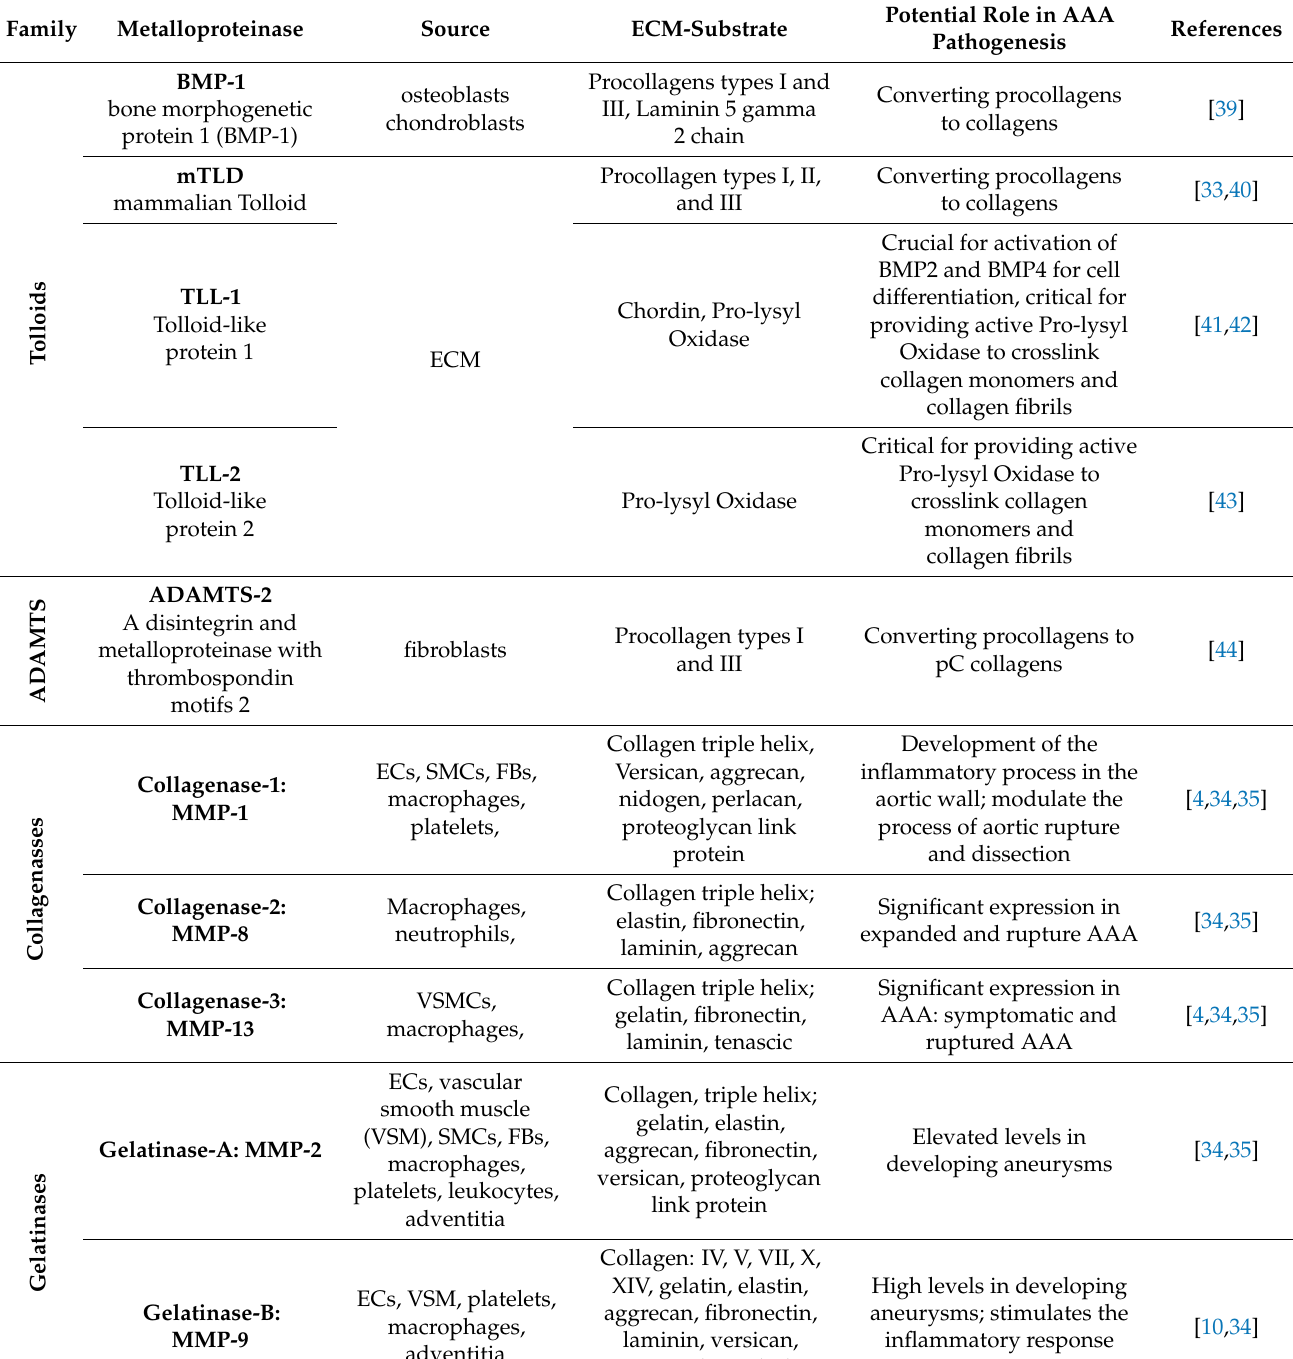
Table 2. Classification of selected metalloproteinase crucial for ECM remodeling and their roles in AAA